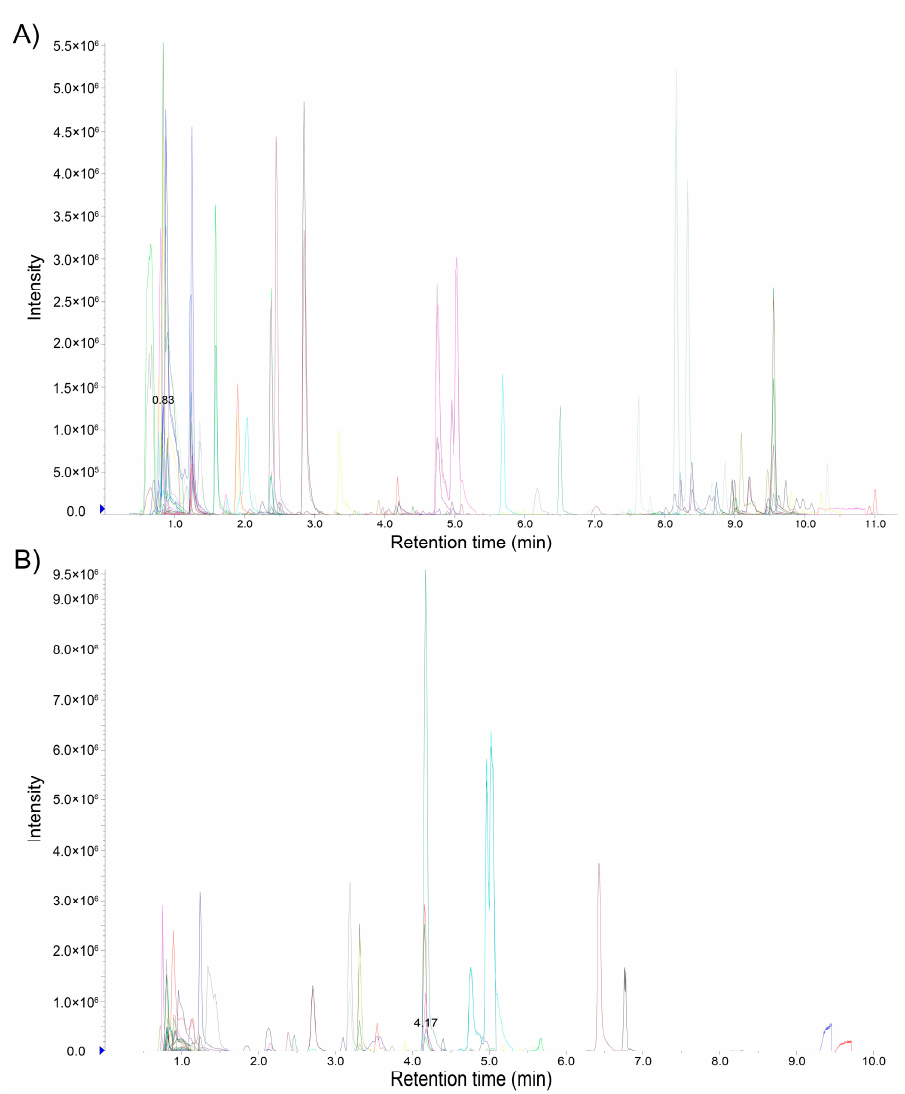
Figure 2. MRM detection of multimodal maps. ( A ), Cationic mode. ( B ), Anion mode.